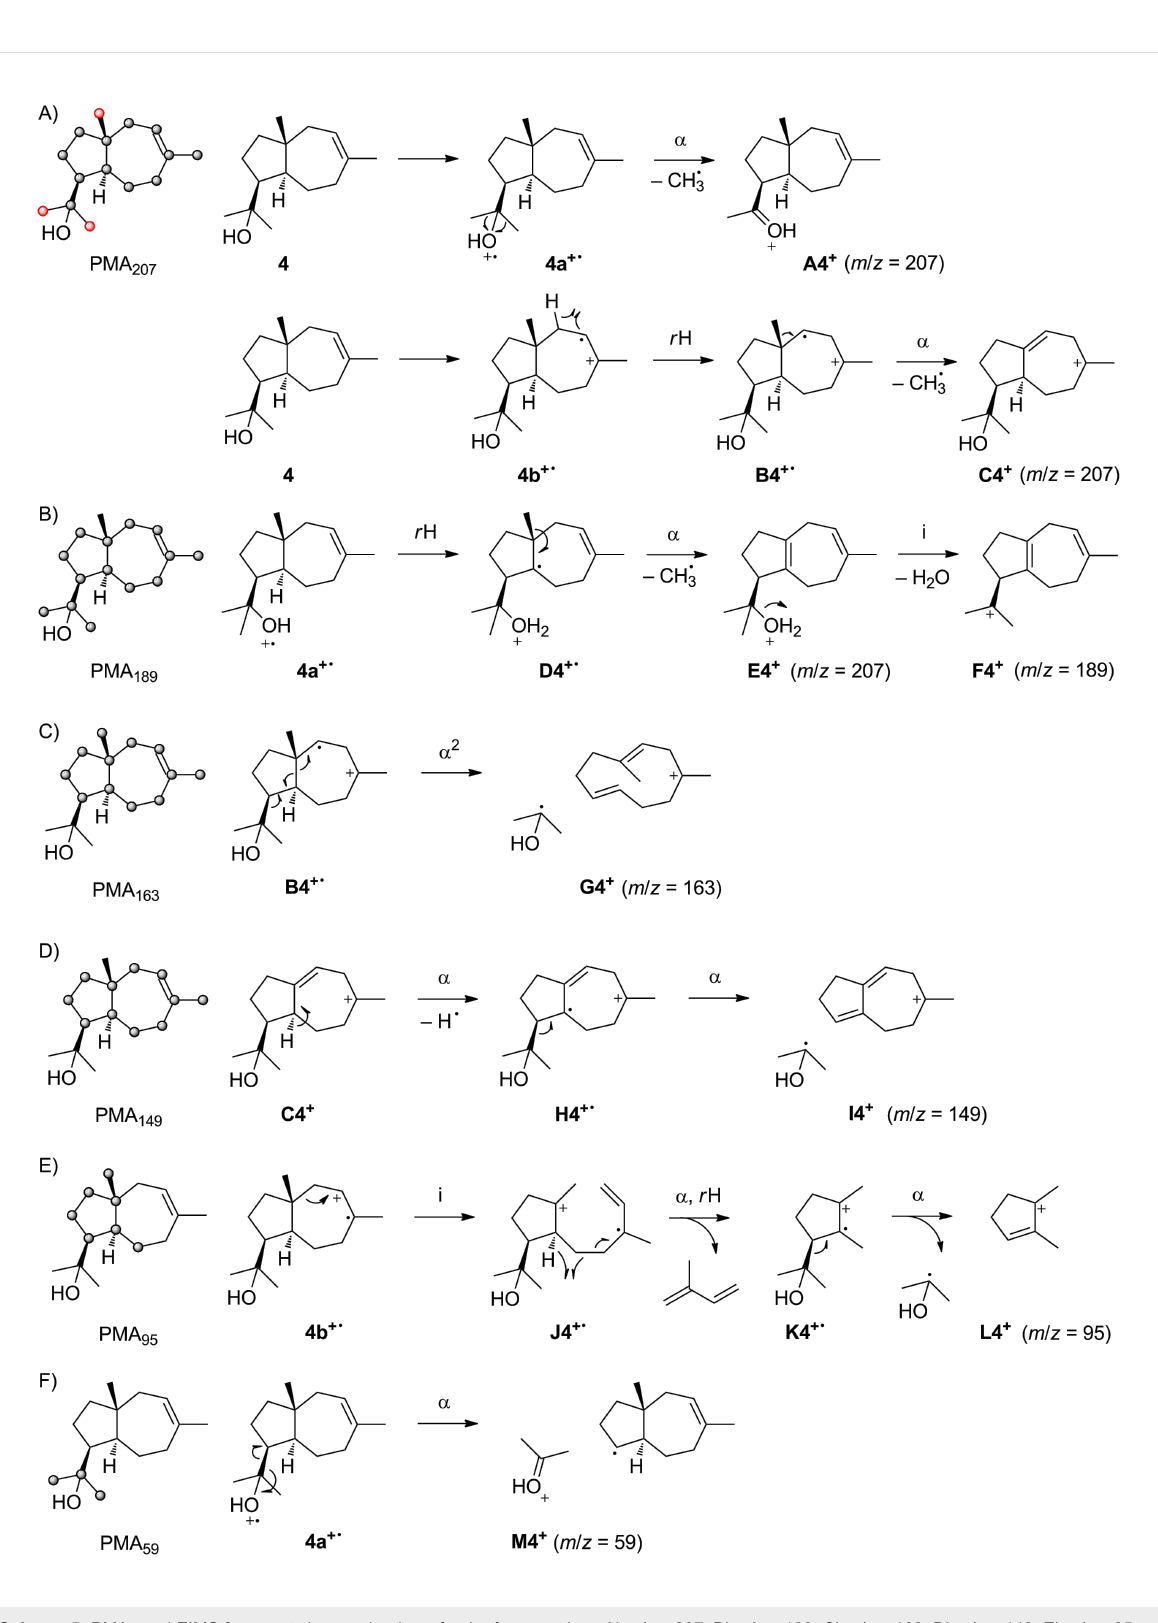
Scheme 5: PMAs and EIMS fragmentation mechanisms for the fragment ions A) m / z = 207, B) m / z = 189, C) m / z = 163, D) m / z = 149, E) m / z = 95 and F) m / z = 59 of 4 . Black carbons contribute fully and red carbons contribute partially to the formation of a fragment ion. α : α -cleavage, r H: hydro- gen rearrangement, i: inductive